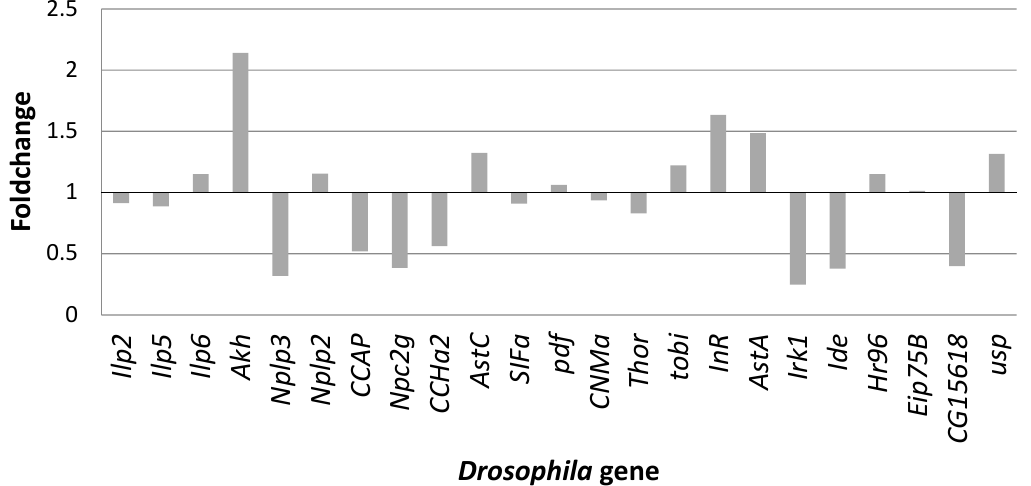
Figure 4. Foldchange in neuropeptide gene expression of wild-type Drosophila melanogaster reared for 12 days on a high-sugar diet, as compared to a normal diet control. Data reported as average of triplicate experiments, as ratio of gene expression values on high-sugar diet to gene expression levels on normal diet control.